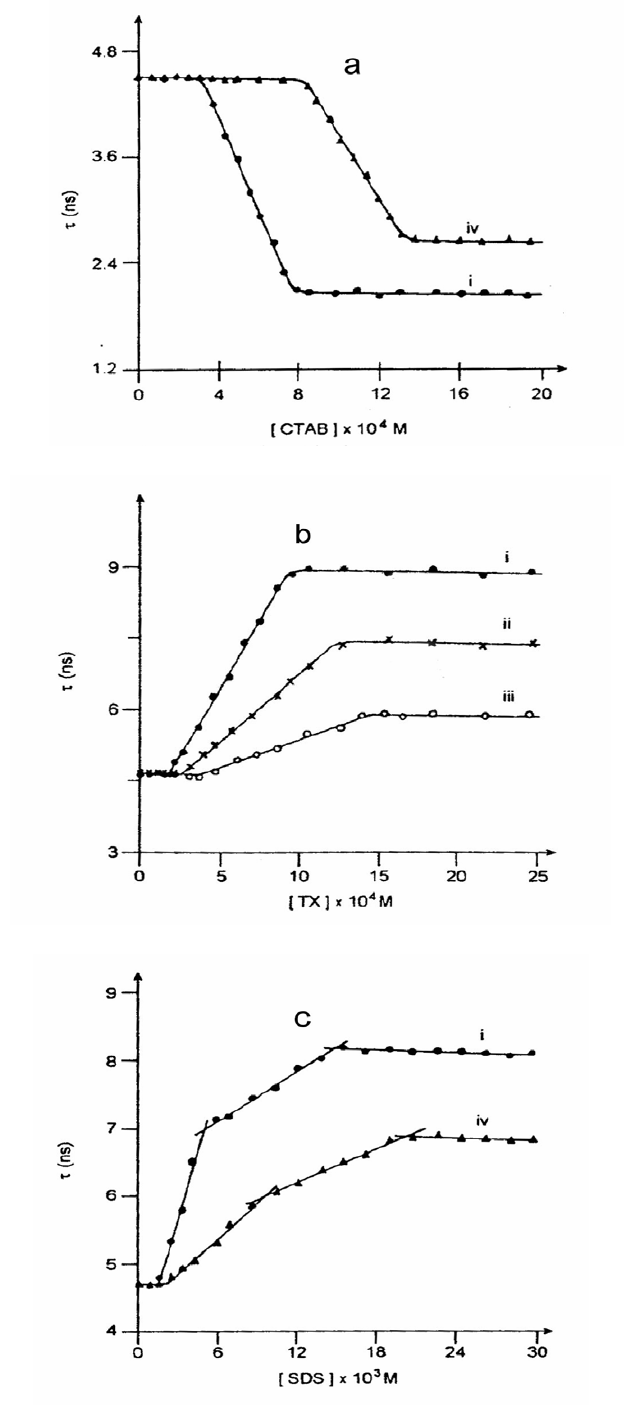
Figure 6. (a) Plot of lifetime of neutral CAZL ( τ in presence of 4.0 molar urea. (b) Plot of lifetime of neutral CAZL ( τ (iii) 2.5 molar urea. (c) Plot of lifetime of neutral CAZL ( τ of 4.0 molar